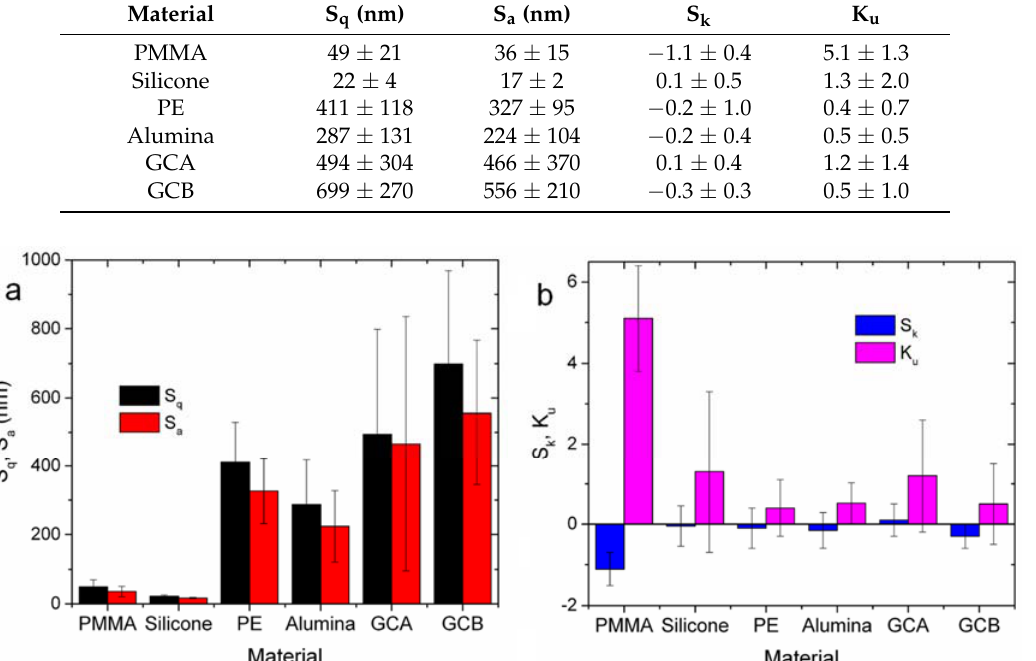
Figure 5. Plot of the topographical parameters of interest, as extracted from images of the surfaces similar to those examples shown in Figure 3: ( a ) roughness parameters S q and S a ; ( b ) height distribution shape parameters, S k and K u .